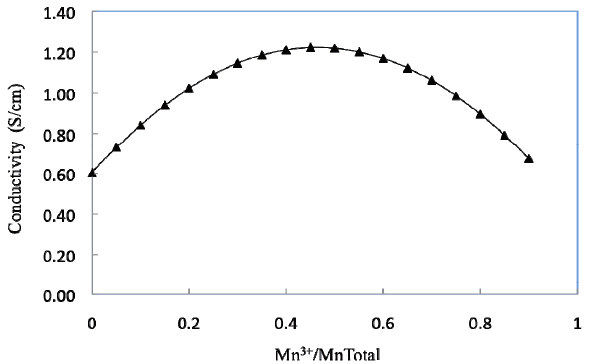
Figure 8. Calculated Total Conductivities as given by the model.